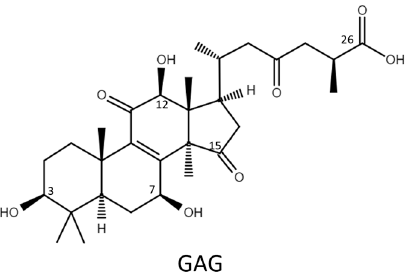
Figure 2. The chemical structure of ganoderic acid G (GAG).